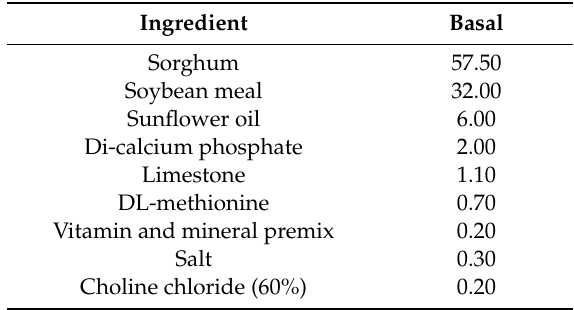
Table 1. Composition of the basal diet (g / kg). Ingredient Basal